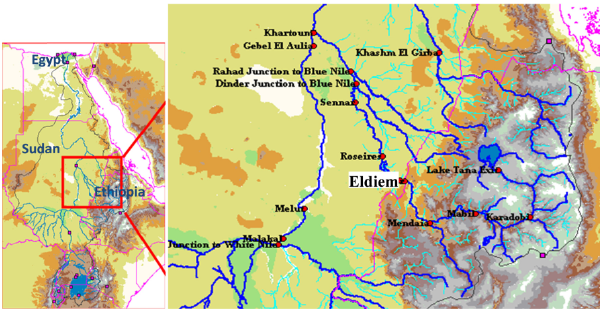
Fig. 2. The topography and geography of cities in the